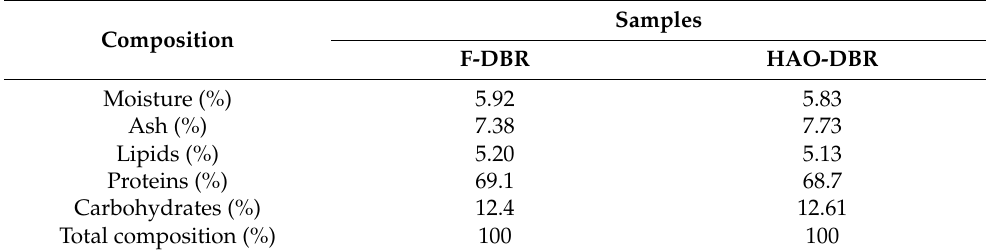
Table 2. Proximate composition of A. platensis dried biomass residue after PC extraction.